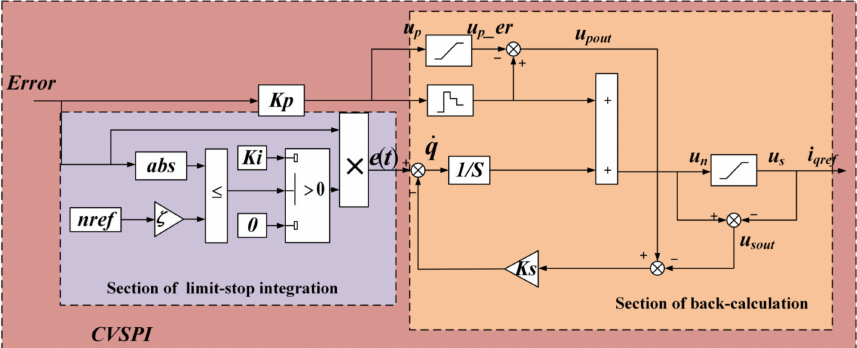
Figure 1. Block diagram of the CVSPI controller